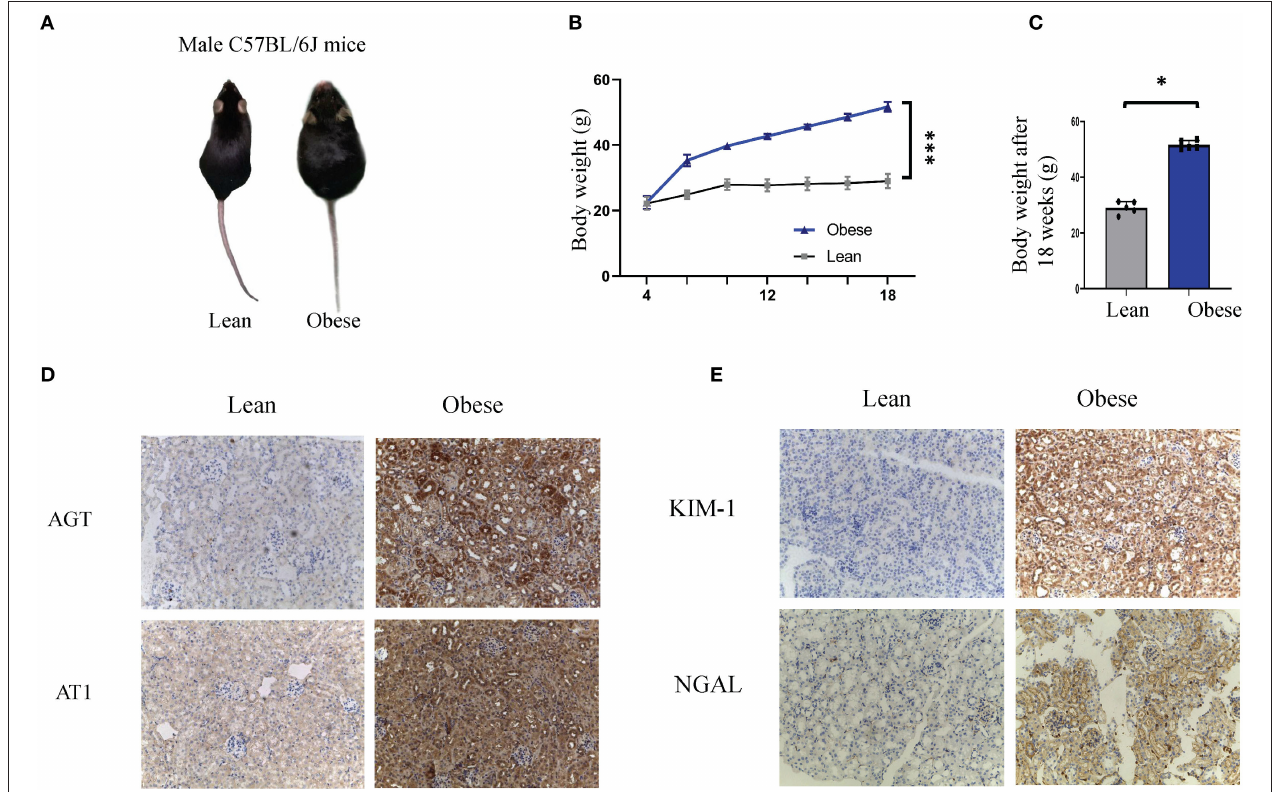
FIGURE 1 | Obesity leads to renal tubule injury and RAS activation in humans and mice. (A–C) Representative images (A) , body weight curves (B) , and bodyweight levels after 18 weeks (C) , of obese and lean mice. (D,E) Representative immunohistochemical staining of AGT, AT1, KIM1, and NGAL in kidney sections of lean and obese mice (Original magnification 200 × ). AGT, angiotensinogen; AT1, angiotensin 1; KIM-1, kidney injury molecule-1; NGAL, neutrophil gelatinase-associated lipocalin. * P < 0.001; *** P <